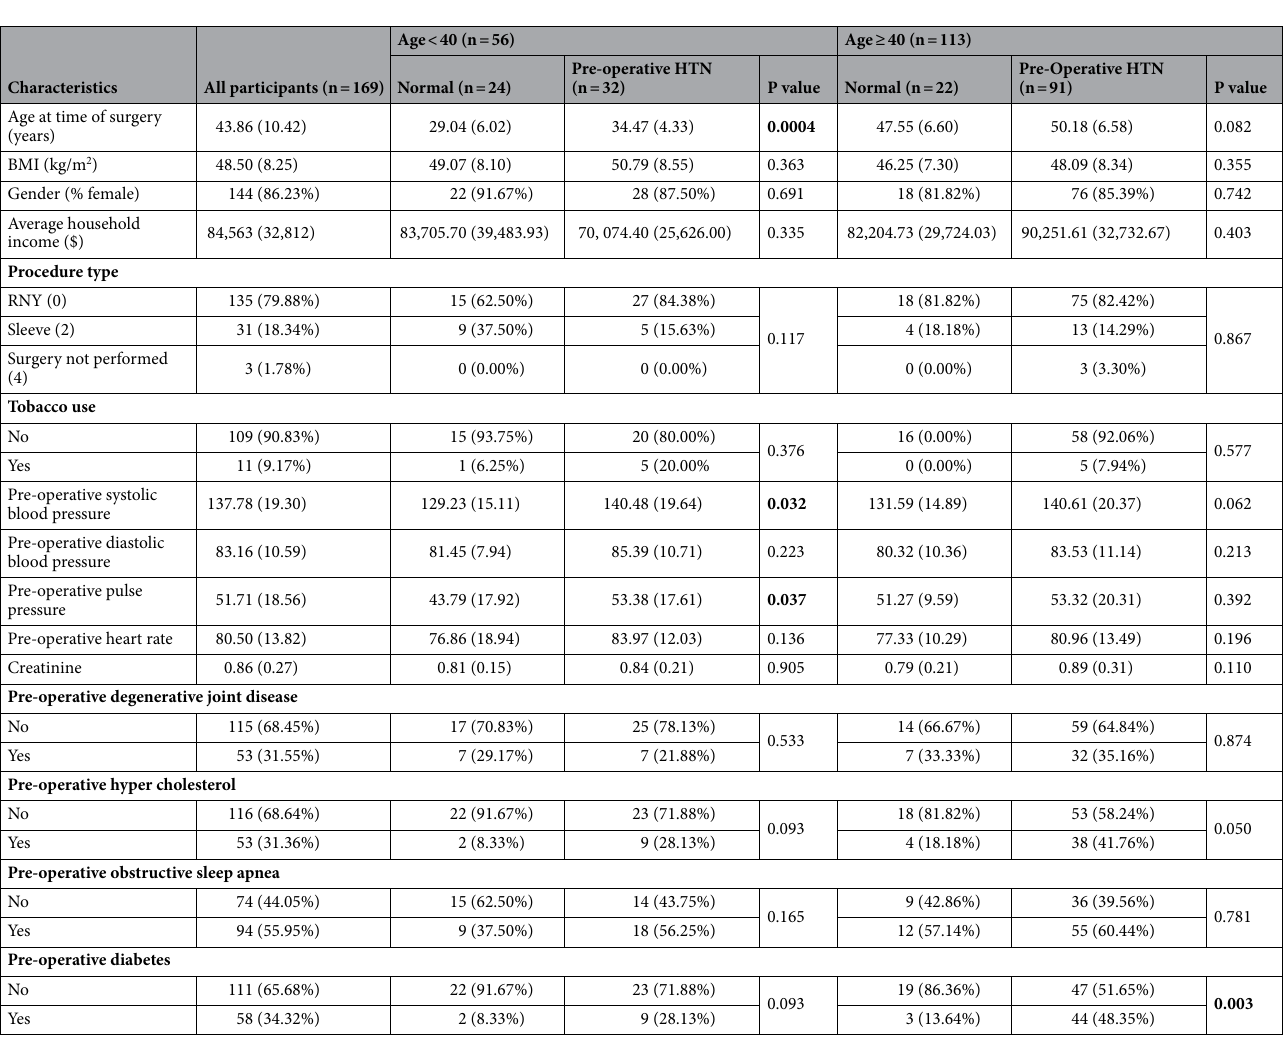
Table 3. Baseline characteristics of obese normotensive vs. obese hypertensive patients by age group. BMI = Body Mass Index (Weight/ Height 2 ); Data are expressed as mean (standard deviation) if numerical variables, or as the number of patients and their percentages (%), if categorical; * Fisher Exact Test; Pre- operative HTN: (1) Patient reported having hypertension and/or required medication at the time of screening; (2) the patient had a systolic blood level ≥ 130 mmHg and/or diastolic levels ≥ 90 mmHg.